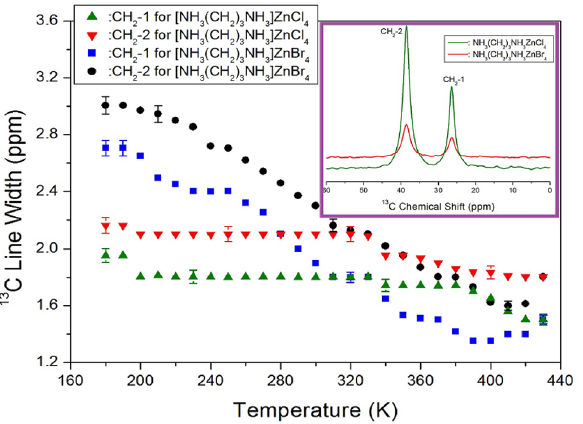
Figure 7. Line widths of 13 C for CH 2 -1 and CH 2 -2 in [NH 3 (CH 2 ) 3 NH 3 ]ZnCl 4 and [NH 3 (CH 2 ) 3 NH 3 ]ZnBr 4 as a function of temperature (Inset: MAS 13 C NMR spectra of [NH 3 (CH 2 ) 3 NH 3 ]ZnCl 4 and [NH 3 (CH 2 ) 3 NH 3 ] ZnBr 4 at 300